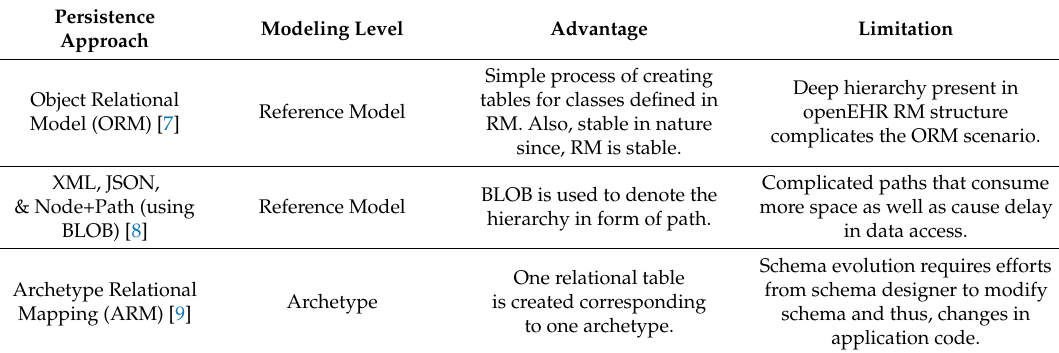
Table 1. openEHR based persistence